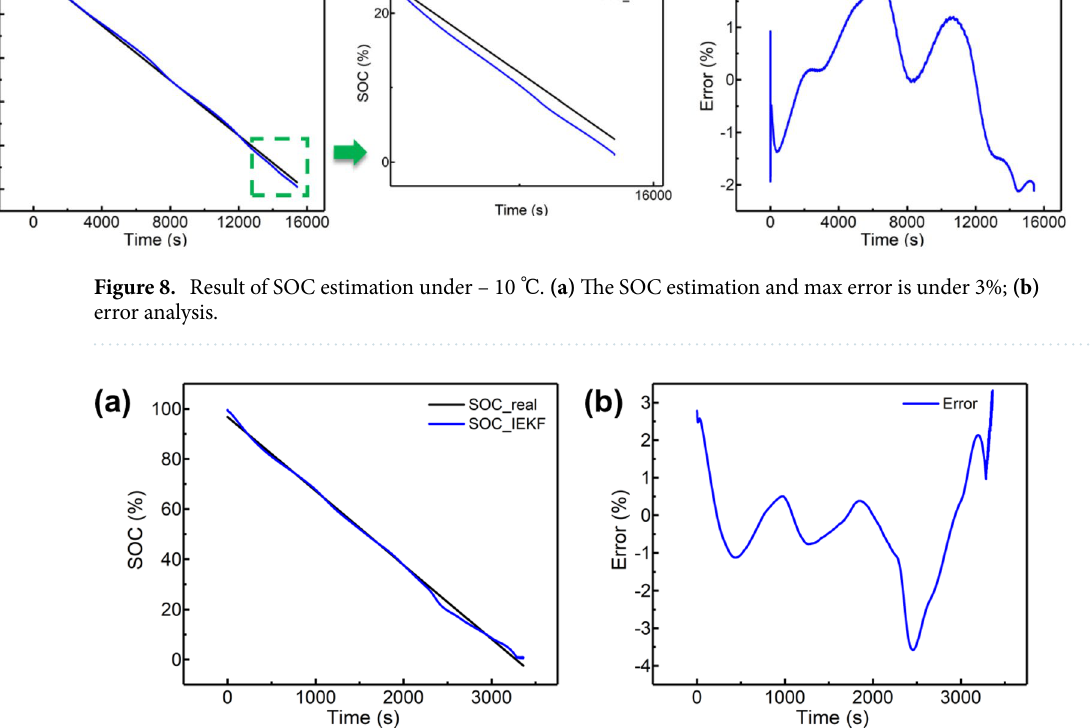
Figure 9. Result of SOC estimation based on lithium iron phosphate battery. (a) SOC estimation result; (b) error analysis.